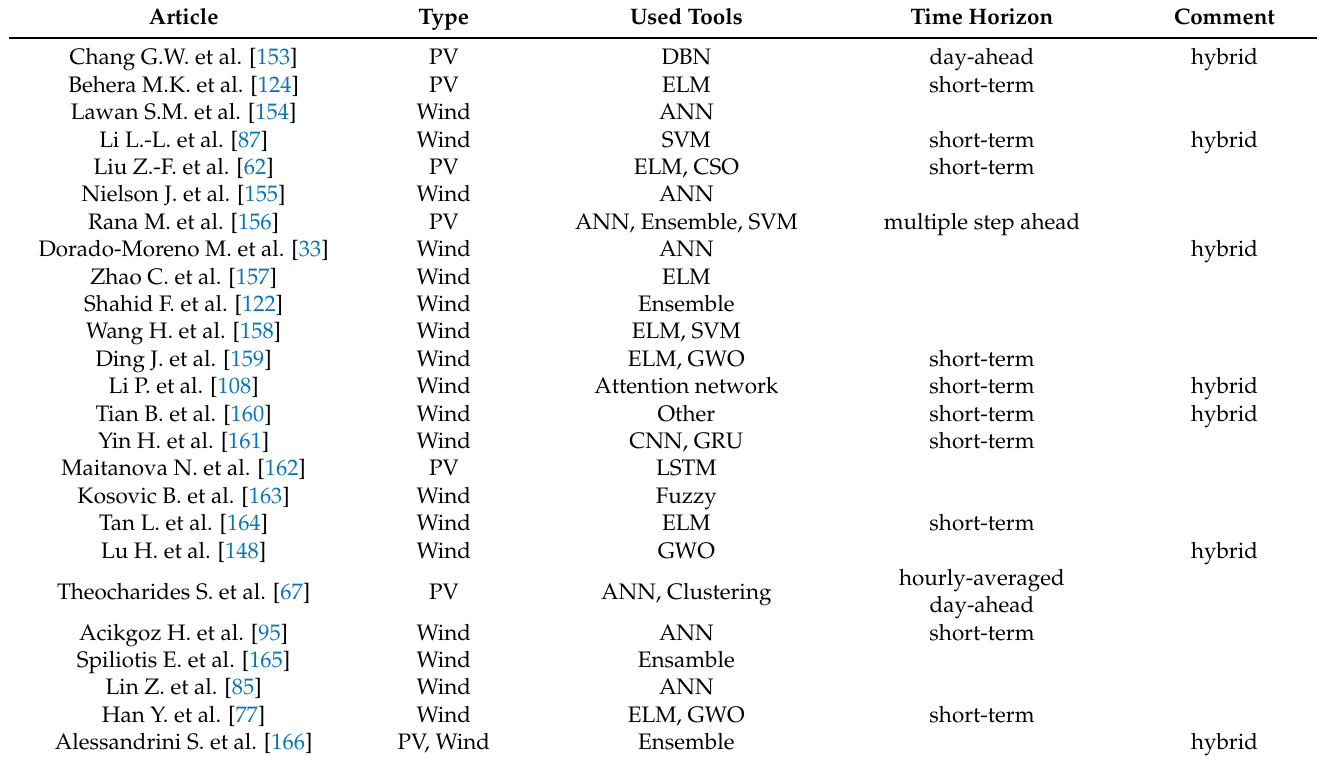
Table A1. An overview and comparative analysis of articles from